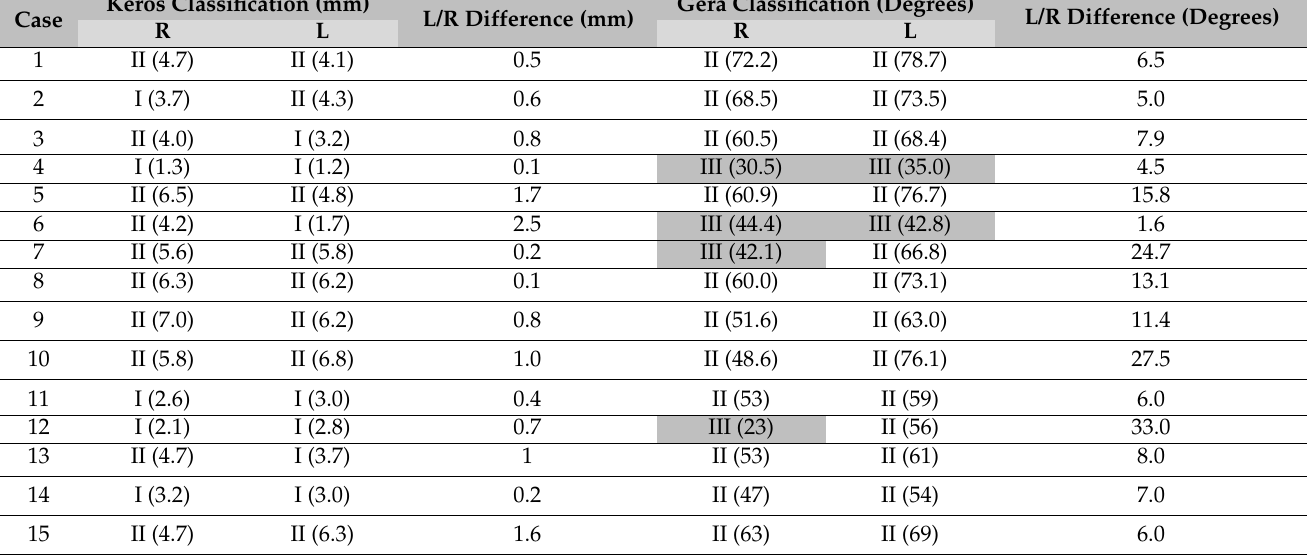
Table 2. Keros vs. Gera classification. Keros I—height difference of <4 mm between cribriform plate (CP) and ethmoid roof (ER). Keros II and III—4–8 mm and >8 mm height differences, respectively. Gera: class I (>80 degrees, low risk), class II (45 to 80 degrees, medium risk), and class III (<45 degrees, high risk), according to the theoretical risk of iatrogenic injuries. Angulation is calculated between the intersection of the horizontal line of the floor of the CP and the lateral lamella of the